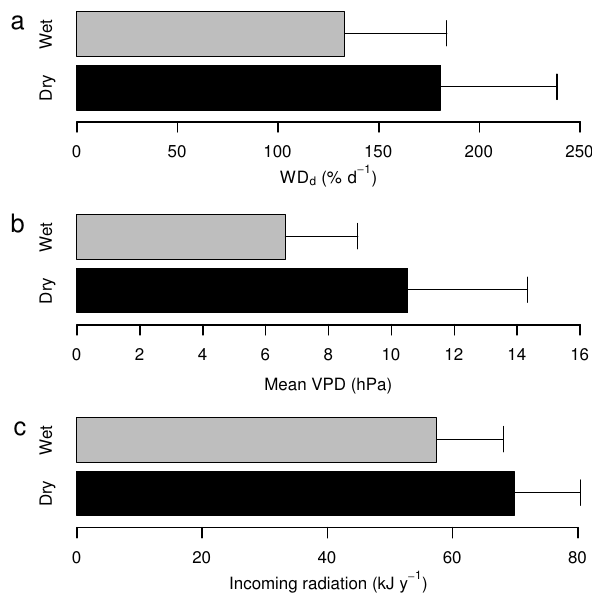
Fig. 5. Average biometeorological conditions for the different pre- cipitation groups: (a) soil water deficit, (b) vapour pressure deficit, (c) incoming radiation (standard errors are